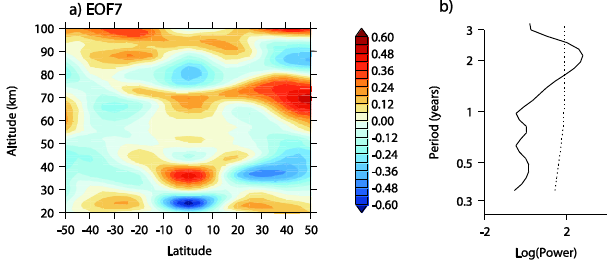
Fig. 5. The seventh EOF (a) and the power spectrum of the PC(7) (b) . The dotted line denotes the 95% confidence level.